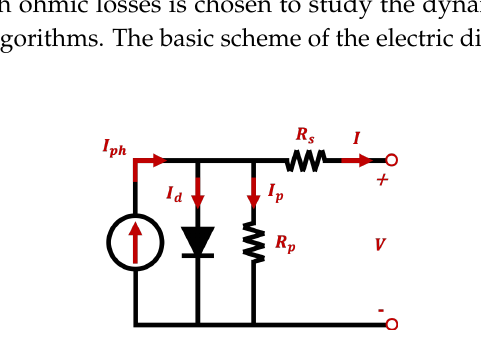
Figure 1. Single diode model with ohmic losses for Photovoltaic systems (PV)